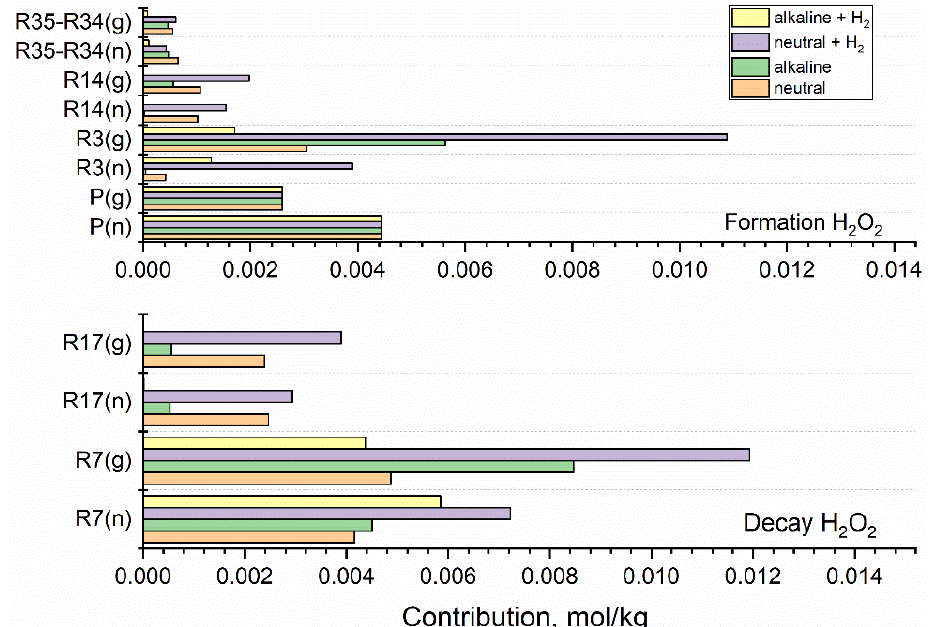
Figure 7. Integrated contributions of key reactions responsible for the formation and decay of H 2 O 2 calculated for fast neutron (n) and gamma (g) radiolysis of neutral water, alkaline solution, and hydrogenated (3 · 10 − 5 mol · kg − 1 H 2 ) neutral and alkaline systems. Integrated production rates are represented by P(g) and P(n). Based on the simulation for 1 kGy · s − 1